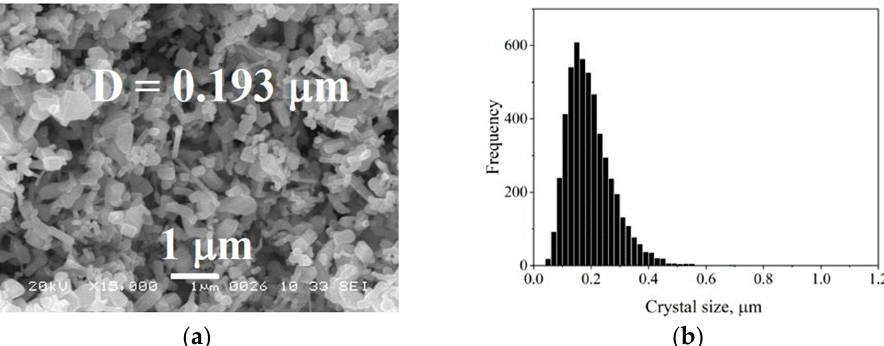
Figure 3. Characteristics of the initial ZnO powder: ( a ) SEM micrograph (Reprinted from Ref. [33], copyright (2019), with